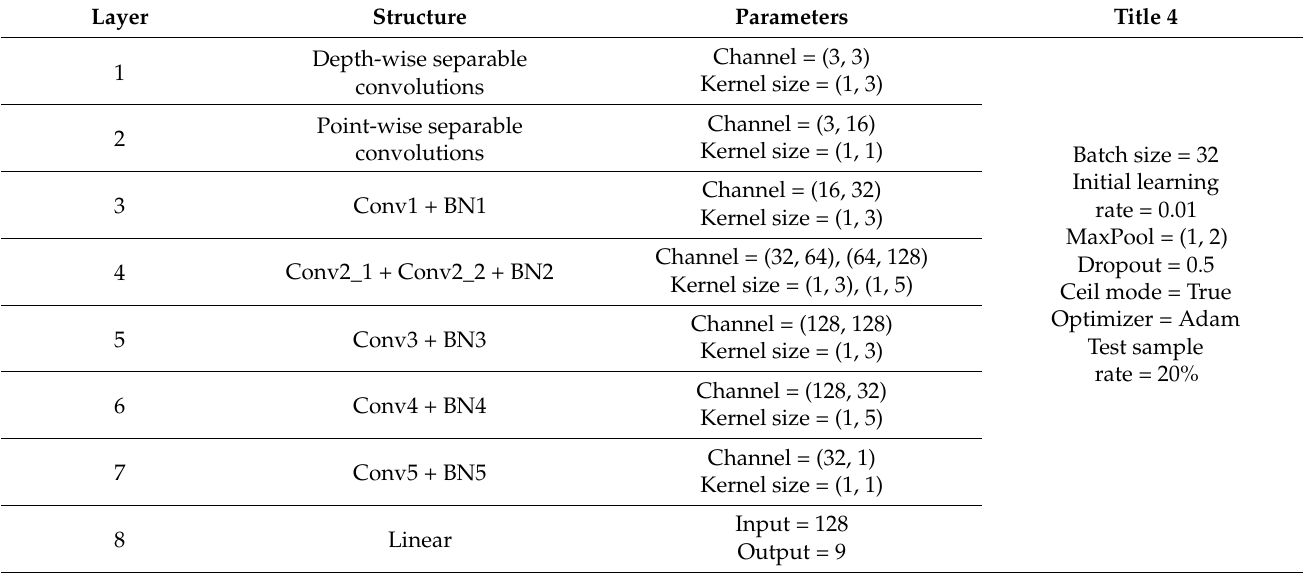
Table 2. Structure and parameters of DWSC and other layers.